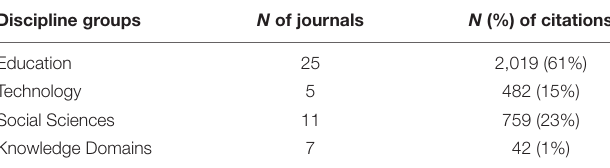
TABLE 5 | List of major journals that CSCL research cites. TABLE 6 | Discipline groups of the journals that CSCL research cites.